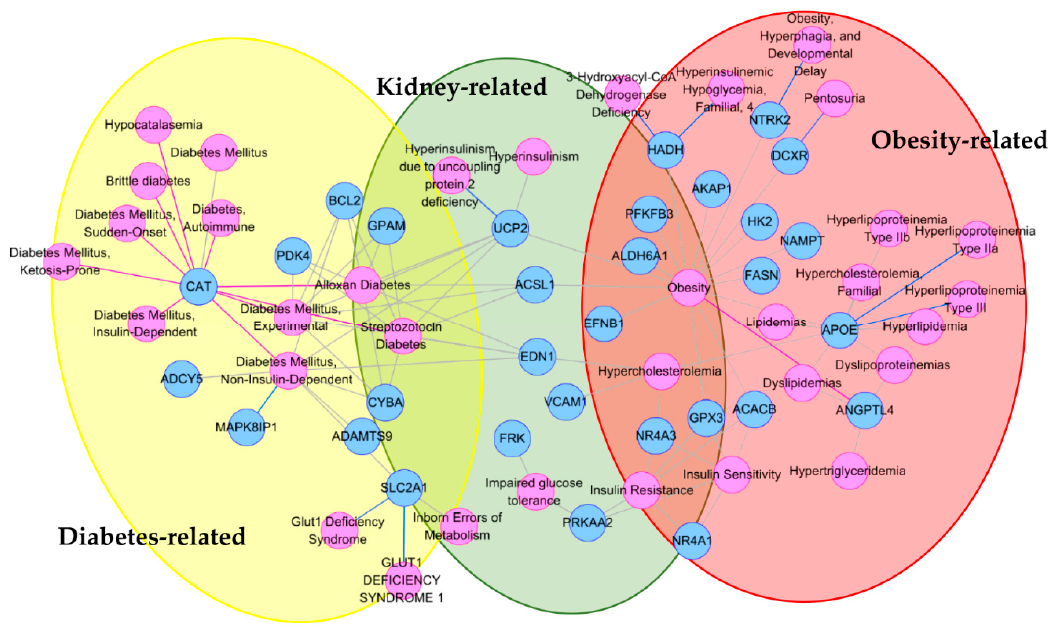
Figure 3. The gene–disease network for metabolic diseases. Pink nodes indicate disease names. Blue nodes represent the subsets of genes identified in our results. Red, yellow, and green circles correspond to obesity-, diabetes-, and kidney-related diseases, respectively.